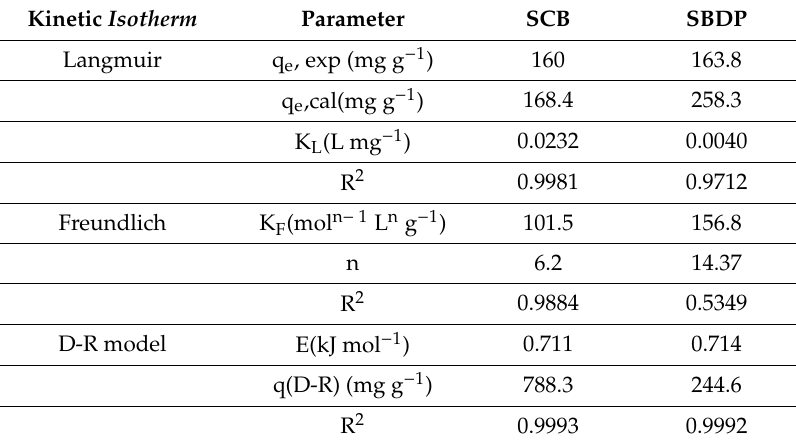
Table 2. Sorption